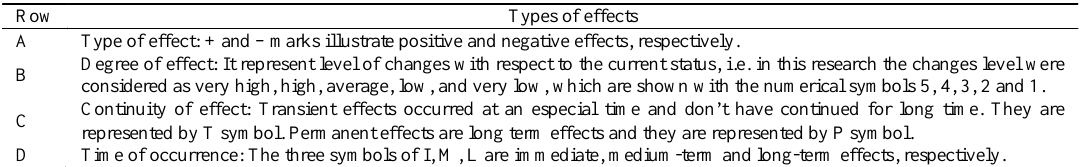
Table 1: Description of types of effects in ICOLD matrix